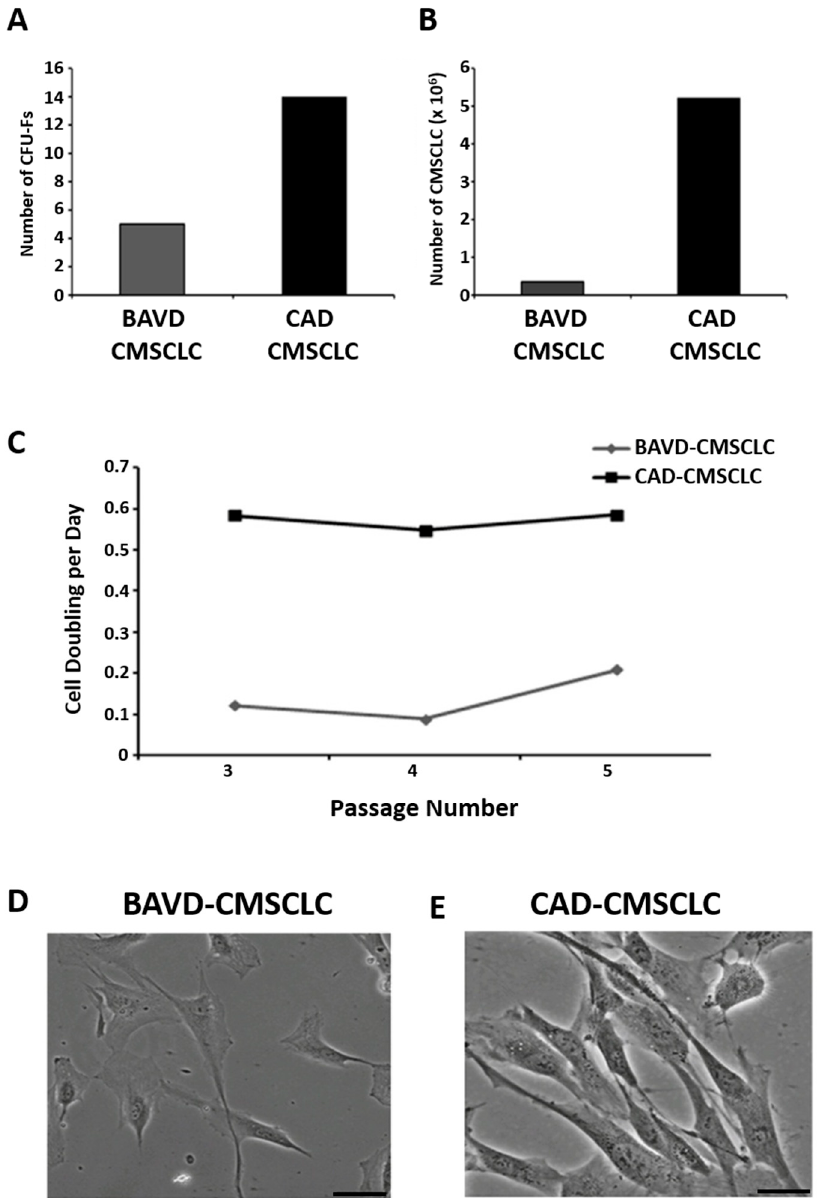
Figure 1. Derivation and characterization of CMSCLC from BAVD and CAD tissue. ( A ) Derivation of CMSCLC from BAVD and CAD cardiac tissue was quantified by counting the formation of established CFU-Fs. ( B ) Total number of CMSCLC counted from established CFU-Fs. ( C ) Quantification of cell doubling per day for BAVD-CMSCLC and CAD-CMSCLC over passages 3–5 of in vitro culture. ( D , E ) Brightfield images of BAVDMSCs and CADMSCs. Scale bar = 50 μ m . Metabolic activity was also measured using an alamarBlue ® assay normalized to total DNA and was lower in BAVD-CMSCLC compared to CAD-CMSCLC (Figure 4B). CMSCCL were also stained and analyzed for cell cycle progression, which showed a population of BAVD-CMSCLC in G2/M phase, whereas the bulk of CAD-CMSCLC were in the G0/G1 phase of the cell cycle (Figure